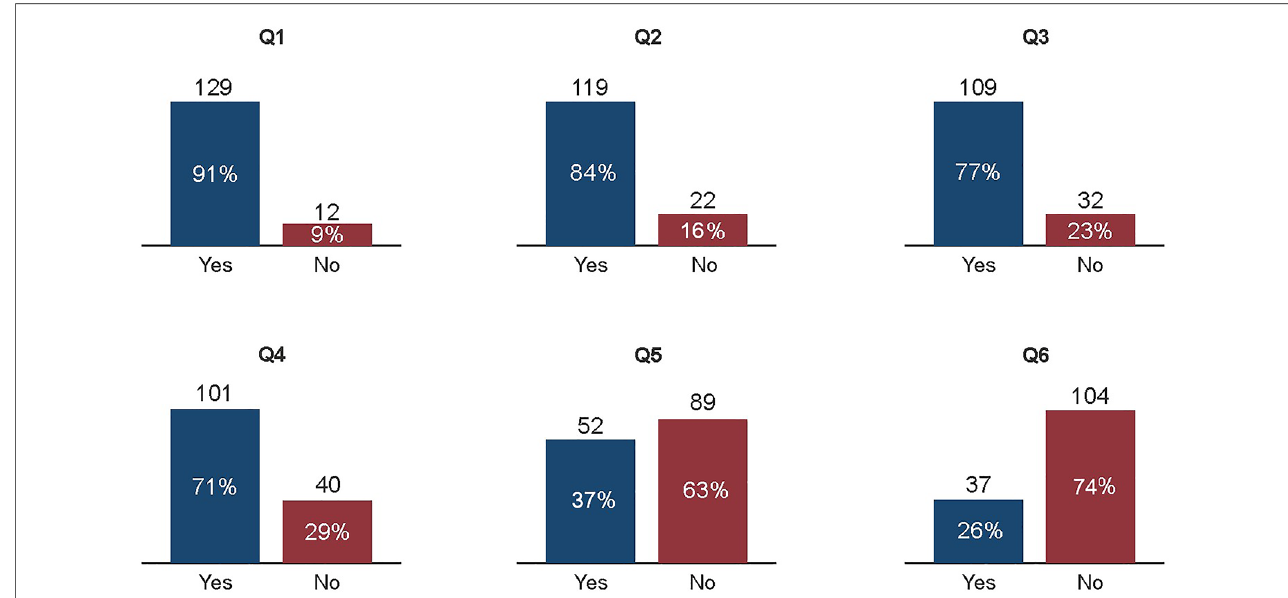
FIGURE 1 Graphic summary of the collected data. Q, Question. (Q1) Is FH a hereditary disease? (Q2) Are you aware of long-term adverse health effects of FH? (Q3) Do you know the reference values of cholesterol needed to establish the diagnosisof FH in children? (Q4) Do you know the prevalence of FH in the general population? (Q5) Are you familiar with the international guidelines for drug treatment of FH? (Q6) Do you have cases with